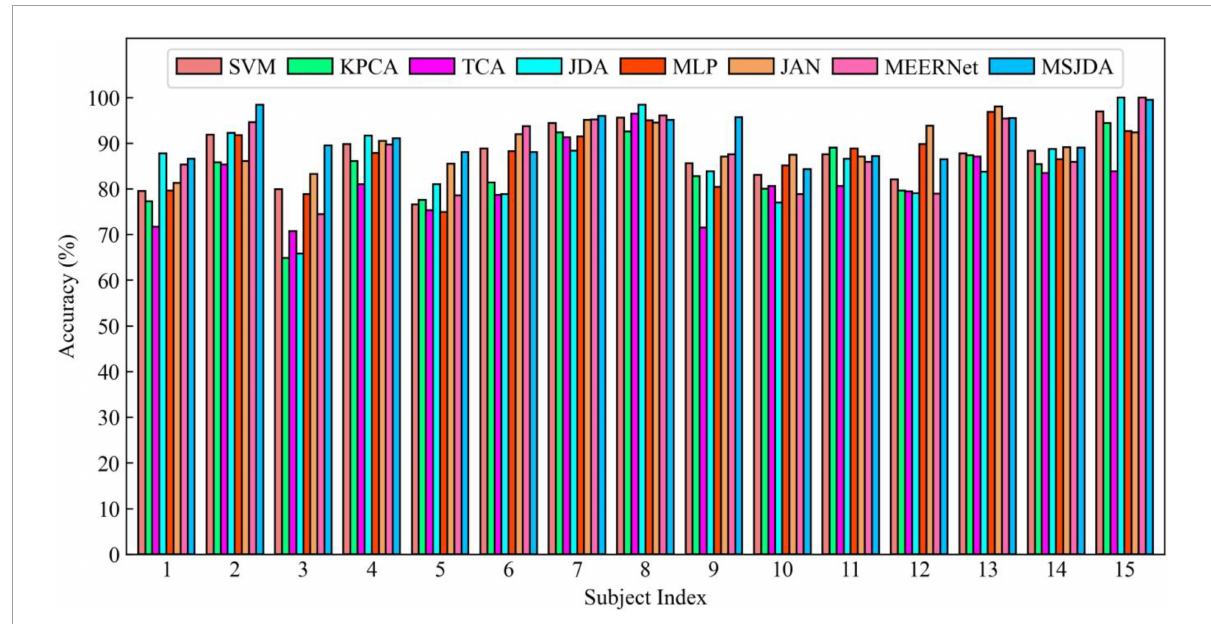
FIGURE6 Results of cross-session experiments for each subject being transferred from their respective source sessions to their first session.